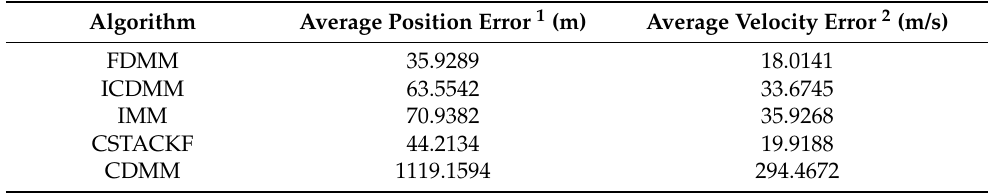
Figure 9. The comparison of the estimated trajectories to the true trajectory in one Monte Carlo run in Case 1. Table 3. The average tracking error of the total tracking process.